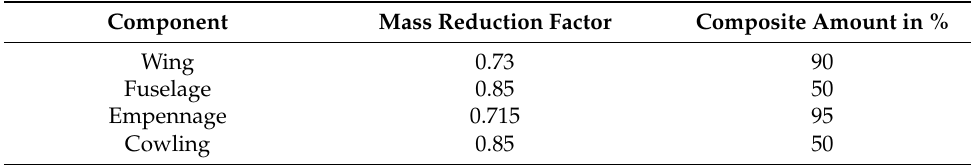
Table 3. Component mass reduction factor and composite